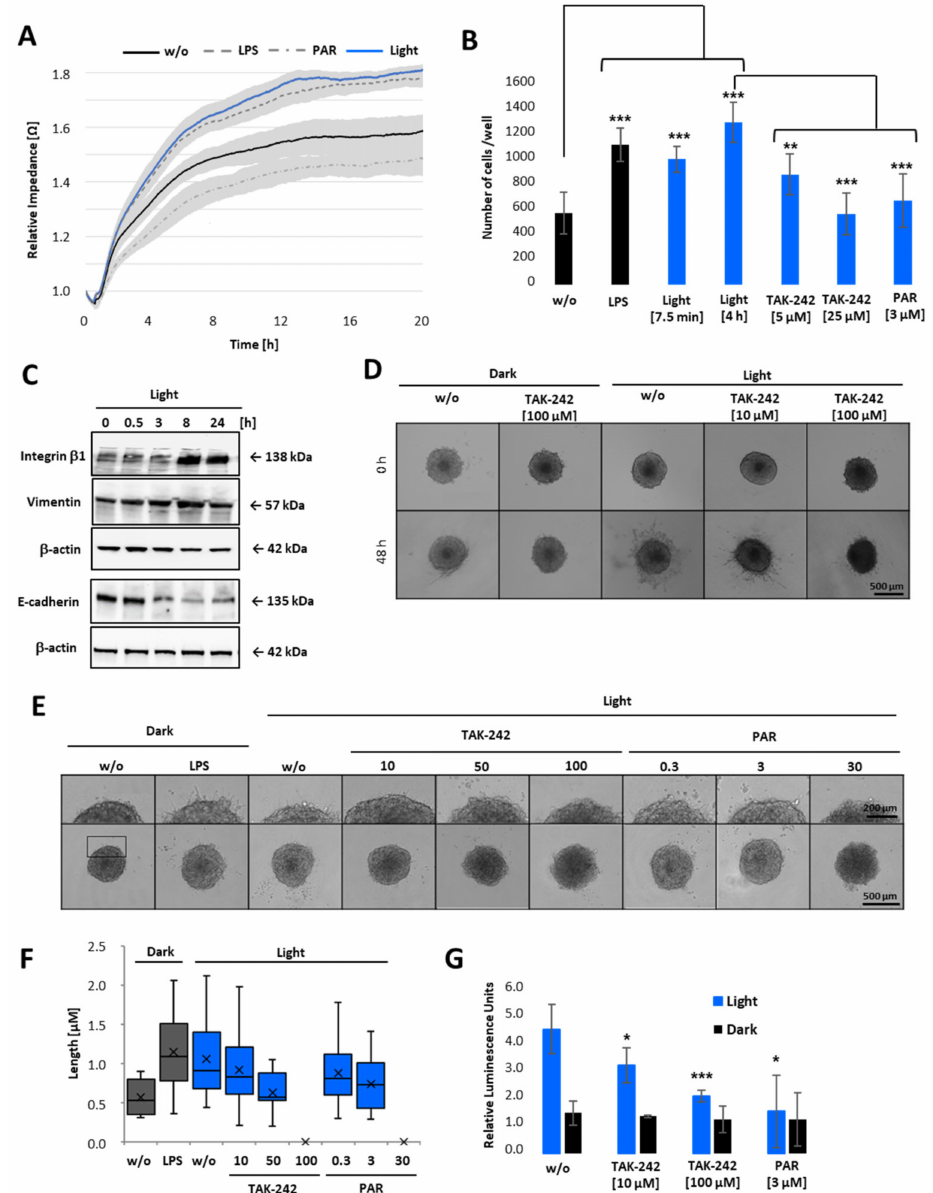
Figure 7. Cell attachment and 3D invasion assay of opto-TLR4 PANC-1 spheroids after light in- duction. ( A ) Opto-TLR4 PANC-1 cells (30,000/well) were transferred to non-adhering plates and exposed to light at 470 nm or treated with 100 ng/mL LPS, 3 µ M PAR, or left untreated for 6 h and seeded onto ECIS array (pre-coated with Col. I) and allowed to attach and spread for a further 20 h. ( B ) Cells were non-treated, treated with LPS, or exposed to light for 7.5 min (+6 h in the dark) or continuously for 6 h and treated with different concentrations of TAK-242 or PAR in non-adhering plates and seeded on pre-coated collagen I plates for 30 min, washed and remaining cells counted. ( C ) Western blot analysis of whole-cell extracts with antibodies against integrin β -1, vimentin, and E-cadherin after light exposure (0–24 h). ( D ) Spheroids (4 days old; 2000 cells) were embedded in Geltrex/collagen type I matrices and pre-treated 1 h with different concentrations of TAK-242 or PAR and exposed to light, treated with 1 µ g/mL LPS, or left untreated and phase-contrast images taken after 0 and 48 h ( E ) or 12 h after treatment. Invadopodia extensions in 3D spheroids after 12 h light exposure are presented in corresponding images ( D , E ) and as a box-whisker-blot performed at least 3-times in triplicates ( F ). Scale bars: phase-contrast, (10 × magnification) indicates ( D ) 500 µ m or ( E ) 200 µ m. ( G ) NF- κ B promoter-linked Gluc detection after 12 h of light exposure. Post-ANOVA multiple comparisons relative to the control were performed using Dunnett’s test. Error bar = SD. n = 6; * p < 0.05; ** p < 0.01, *** p <